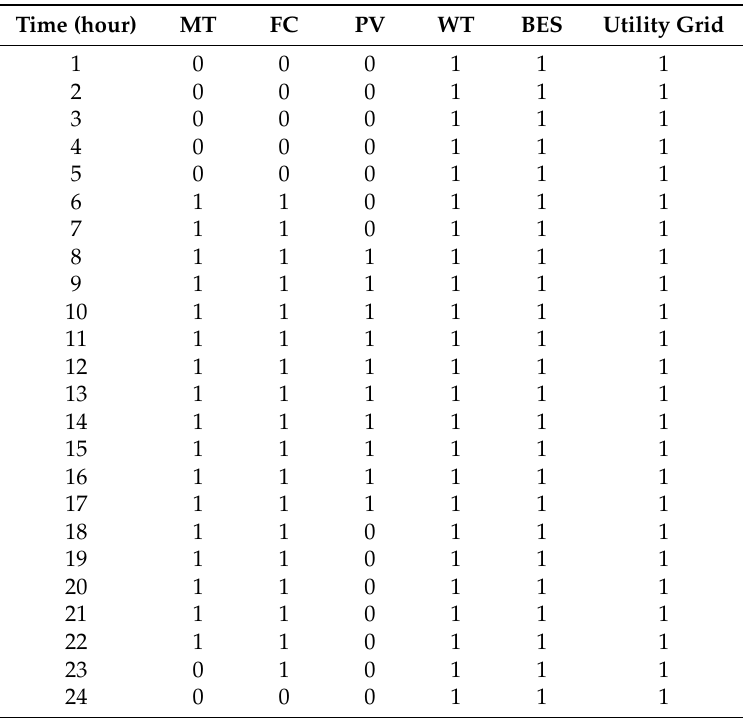
Figure 13. Optimal output of the generation sources obtained by GWO for Scenario C. Table 5. Corresponding status of the generation sources obtained by GWO for Scenario